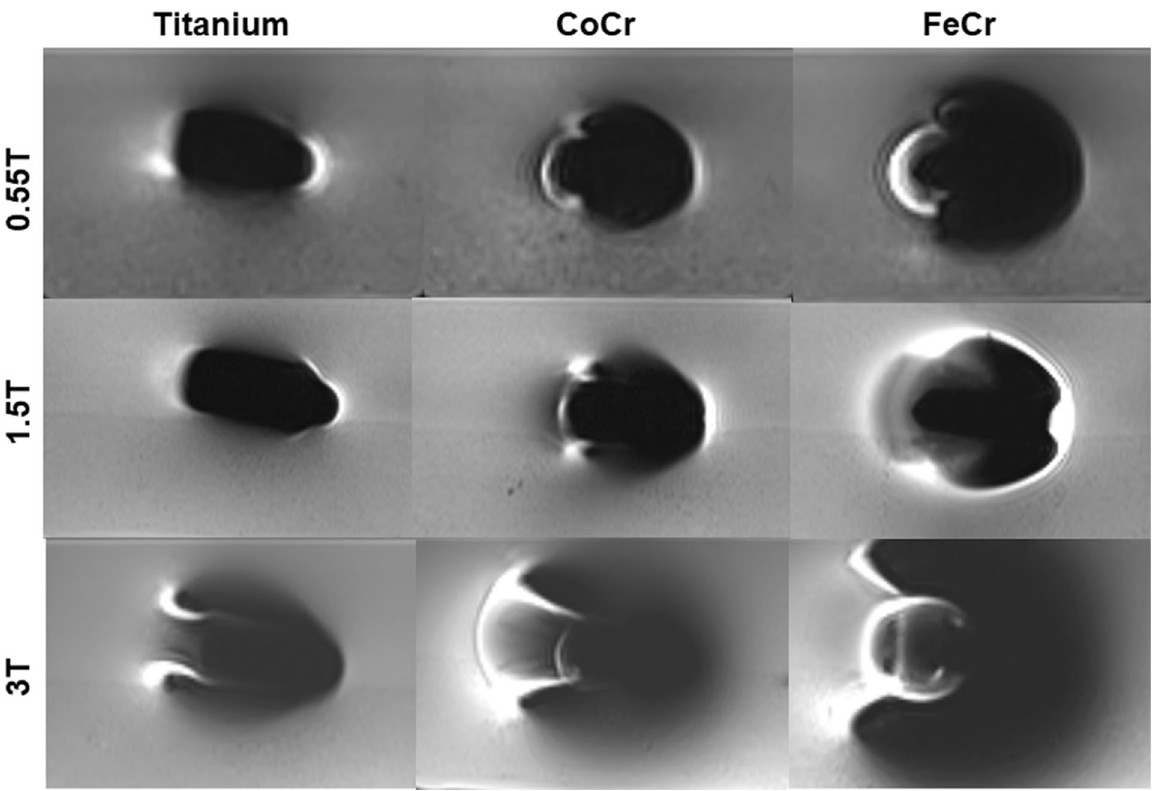
Fig. 5 Axial slices through the femoral components made of three different alloys at 0.55 T, 1.5 T, and 3 T. Artifacts are lowest for Ti and increase with higher magnetic field strength for all three